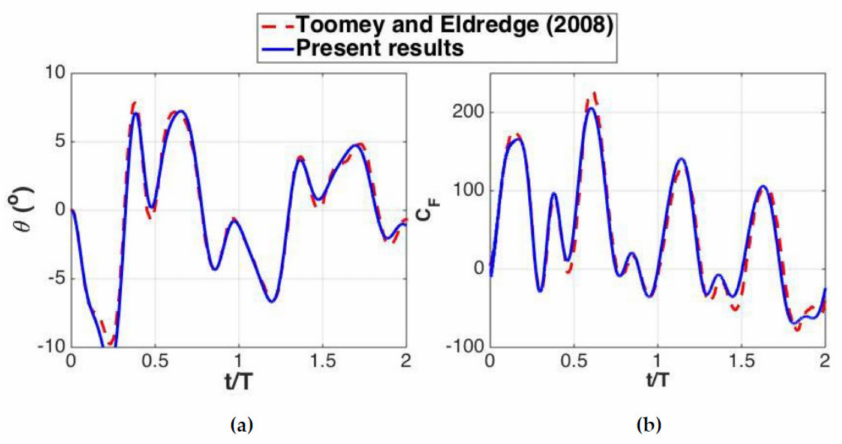
Figure 4. A comparison with the results of previous work, ( a ) induced angle of the lower body, and ( b ) fluid force acting on the